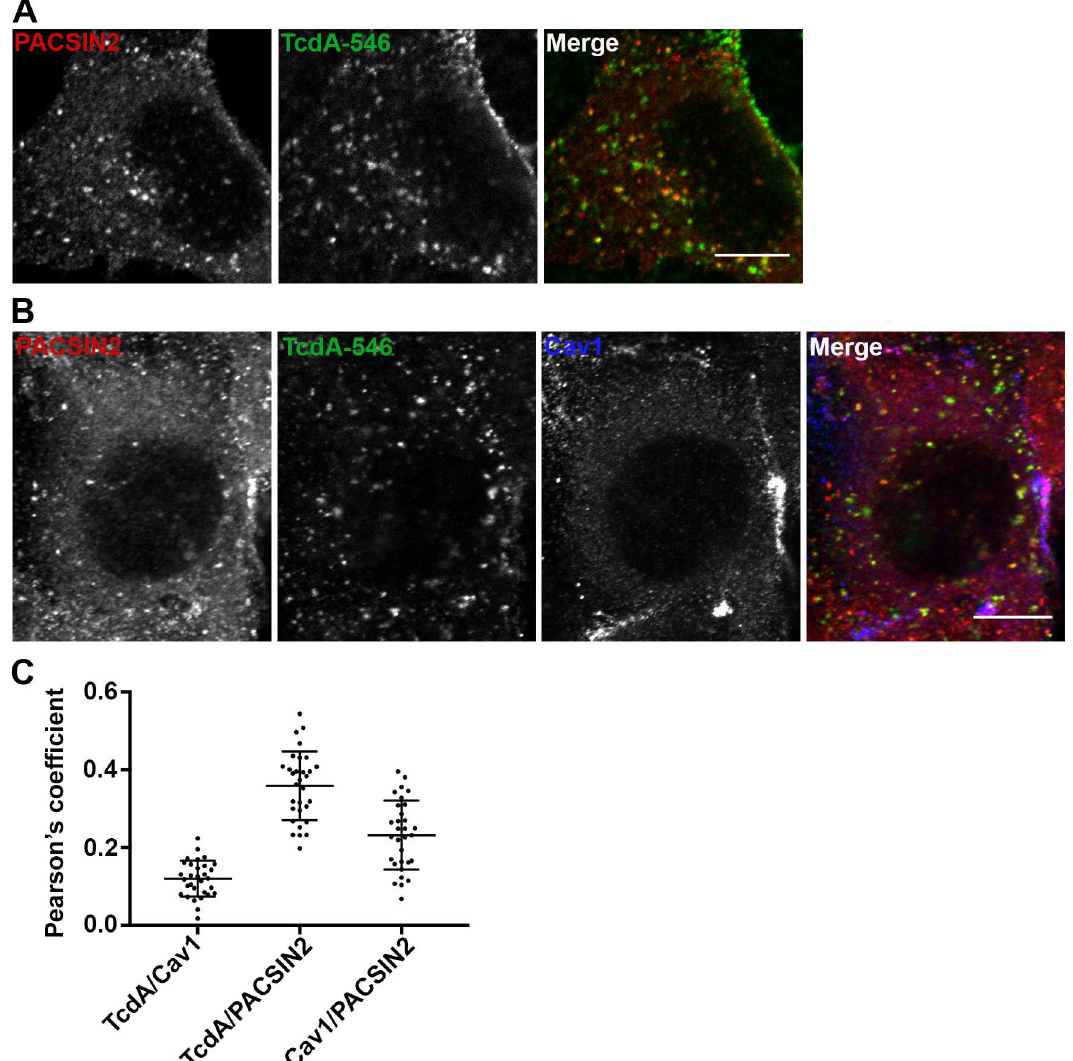
Fig 4. TcdA colocalizes with PACSIN2 in wildtype MEF cells. ( A ) Wildtype MEFs on glass coverslipswere allowedto bind50 nM TcdA-546 for 45 min at 10˚C, and cells were shifted to 37˚C to allowinternalizationof toxin for 3 min. Cells were fixed, stainedfor PACSIN2, and analyzedby confocalmicroscopy. Mergedimages show PACSIN2 in red, toxin in green, and colocalization in yellow. Scale bars, 10 μ m. The images shown are representative of multiplefields imagedfrom two independent experiments. ( B ) Immunofluorescence assays were performed as describedin (A), but cells were stainedfor cav1 in additionto PACSIN2. Merged images show PACSIN2 in red, toxin in green, and cav1 in blue. Yellow puncta in mergedimages denote TcdA- and PACSIN2-positive structures. Pink punta denotecaveolae-associatedPACSIN2. Scale bars, 10 μ m. ( C ) Pearson’scorrelation coefficient to assess the extent of colocalization betweenPACSIN2, cav1 and TcdA- 546 after 3 min toxin uptake. Data representmean and SD of 31 individualcells chosen at random.